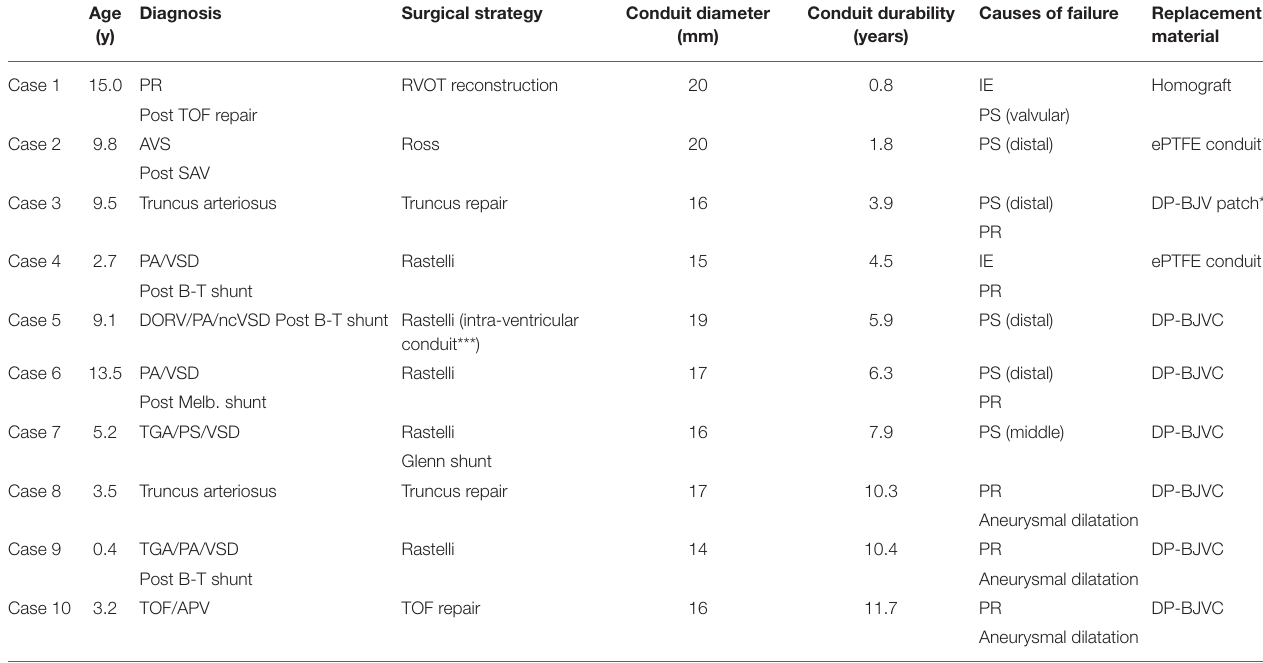
TABLE 3 | Operative data and the causes for explantations ( n = 10). Age Diagnosis Surgical (y)